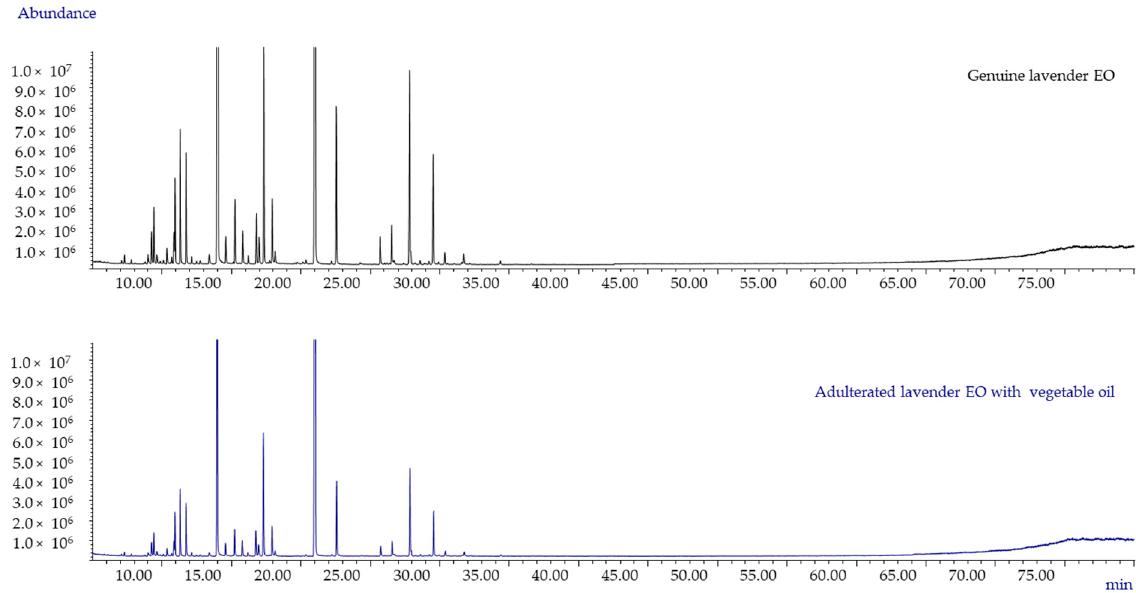
Figure 3. GC-MS patterns of both genuine and spiked on purpose lavender EO (analysed with an oven temperature program up to 300 °C).